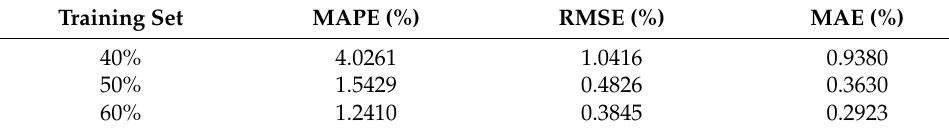
Figure 7. Error of FC1 for degradation prediction with different training set sizes. Table 2. Prediction performance with different training set sizes for